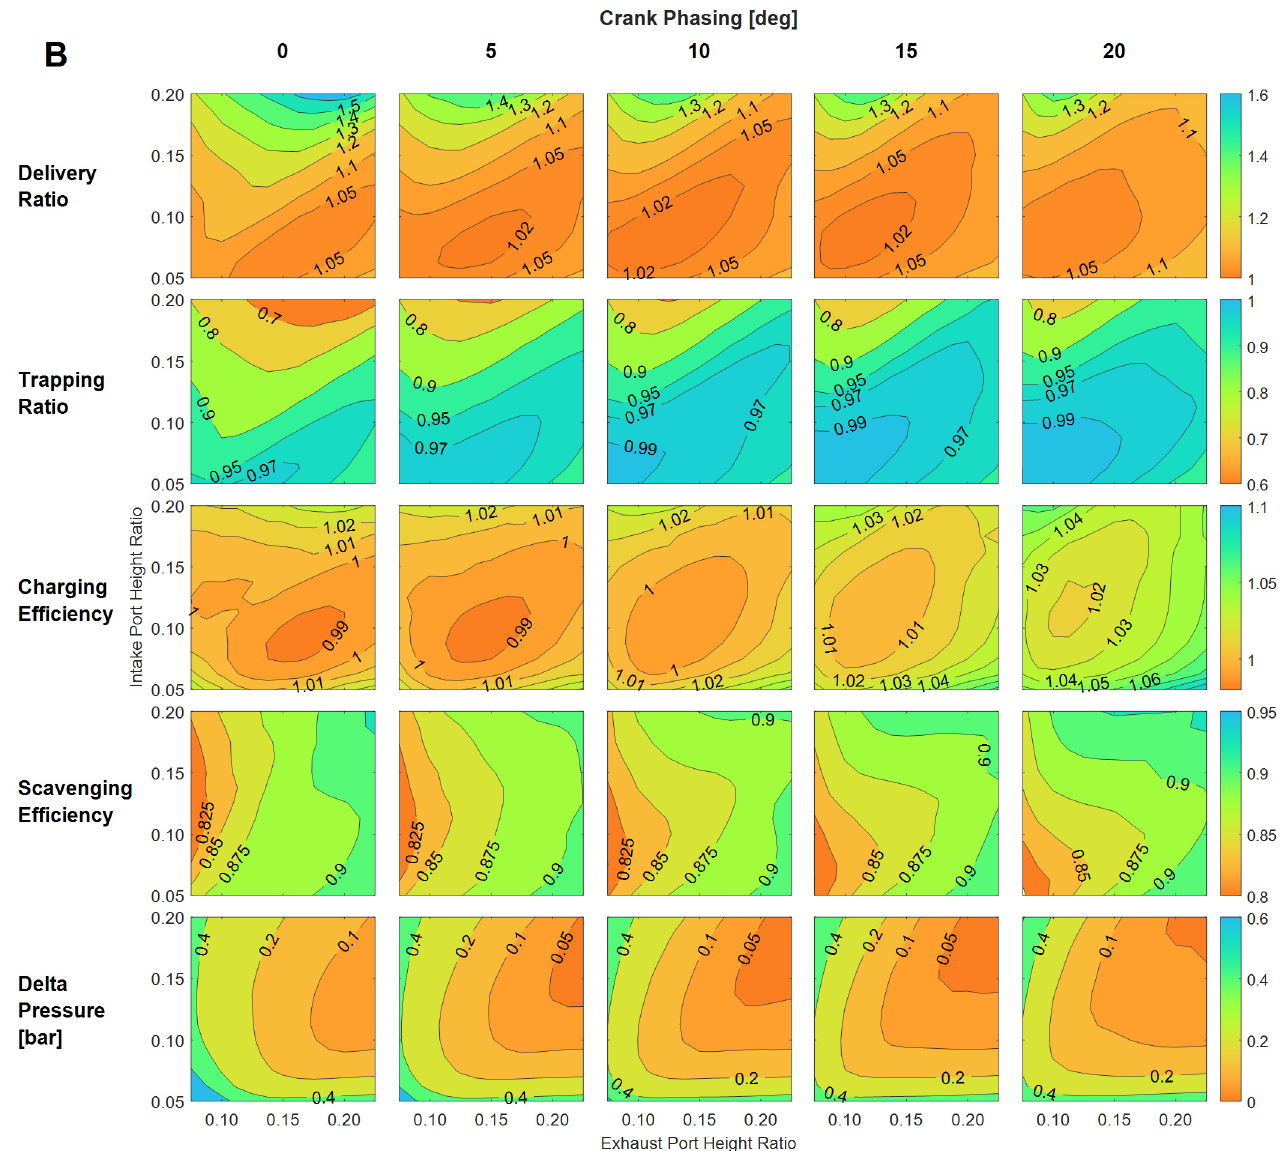
Figure 11. Effect of crankshaft phasing and intake and exhaust port height-to-stroke ratio on delivery ratio, trapping ratio, charging efficiency, scavenging efficiency, and delta pressure, at operating point B (1500 min − 1 , 12-bar BMEP); λ = 1.